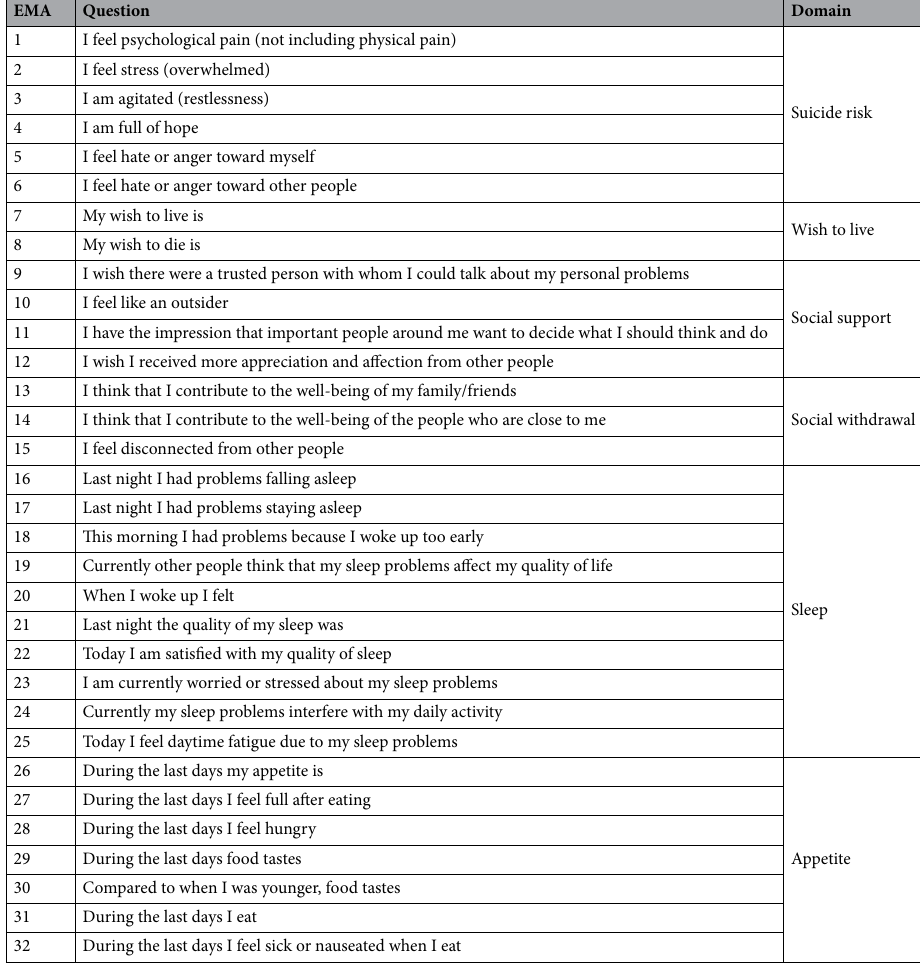
Table 1. EMA questions. Refer to Supplementary Table S1 for the details of the domains and EMA